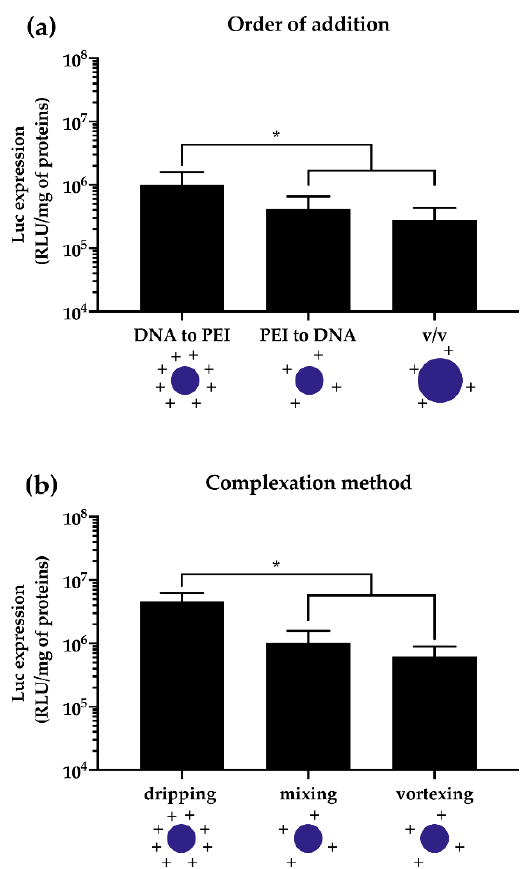
Figure 5. Effect of the complexation method on the transfection efficiency of pDNA/ l PEI complexes at N/P 30 in L929 cells. ( a ) Transfection efficiency of pDNA/ l PEI complexes as a function of the order of mixing and volumes of l PEI and pDNA solutions. Complexes were prepared by adding 160 ng/cm 2 of pGL3 with the l PEI solution in 10 mM Hepes (DNA to PEI), or vice versa (PEI to DNA), then mixing the two solutions by rigorous pipetting, or by mixing equivolumes of DNA and PEI solutions ( v/v ). ( b ) Transfection efficiency of pDNA/ l PEI complexes as a function of the complexation method. Complexes were prepared by adding 160 ng/cm 2 of pGL3 to l PEI in 10 mM Hepes by single dripping, mixing (i.e., repeated and rigorous pipetting), and vortexing. Results are expressed as mean ± SD ( n ≥ 3) (* p < 0.05).